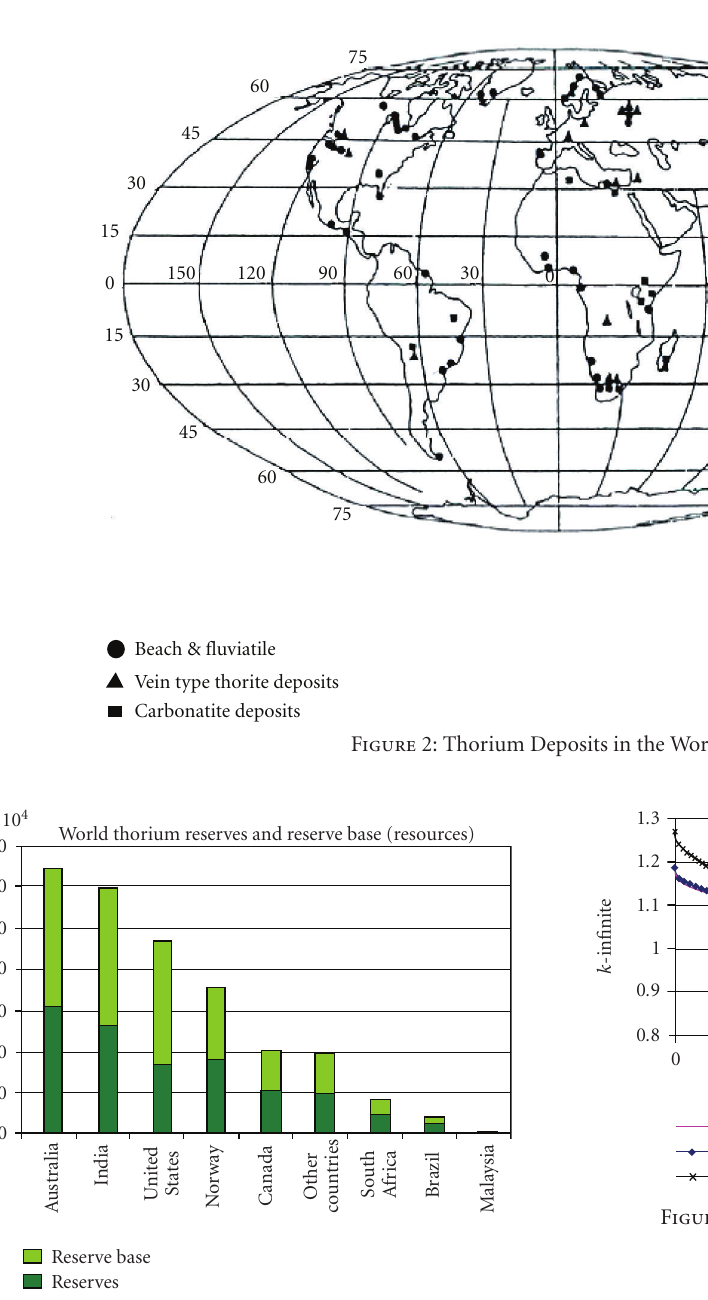
Figure 3: The World Thorium Reserves and Reserve Base [5].